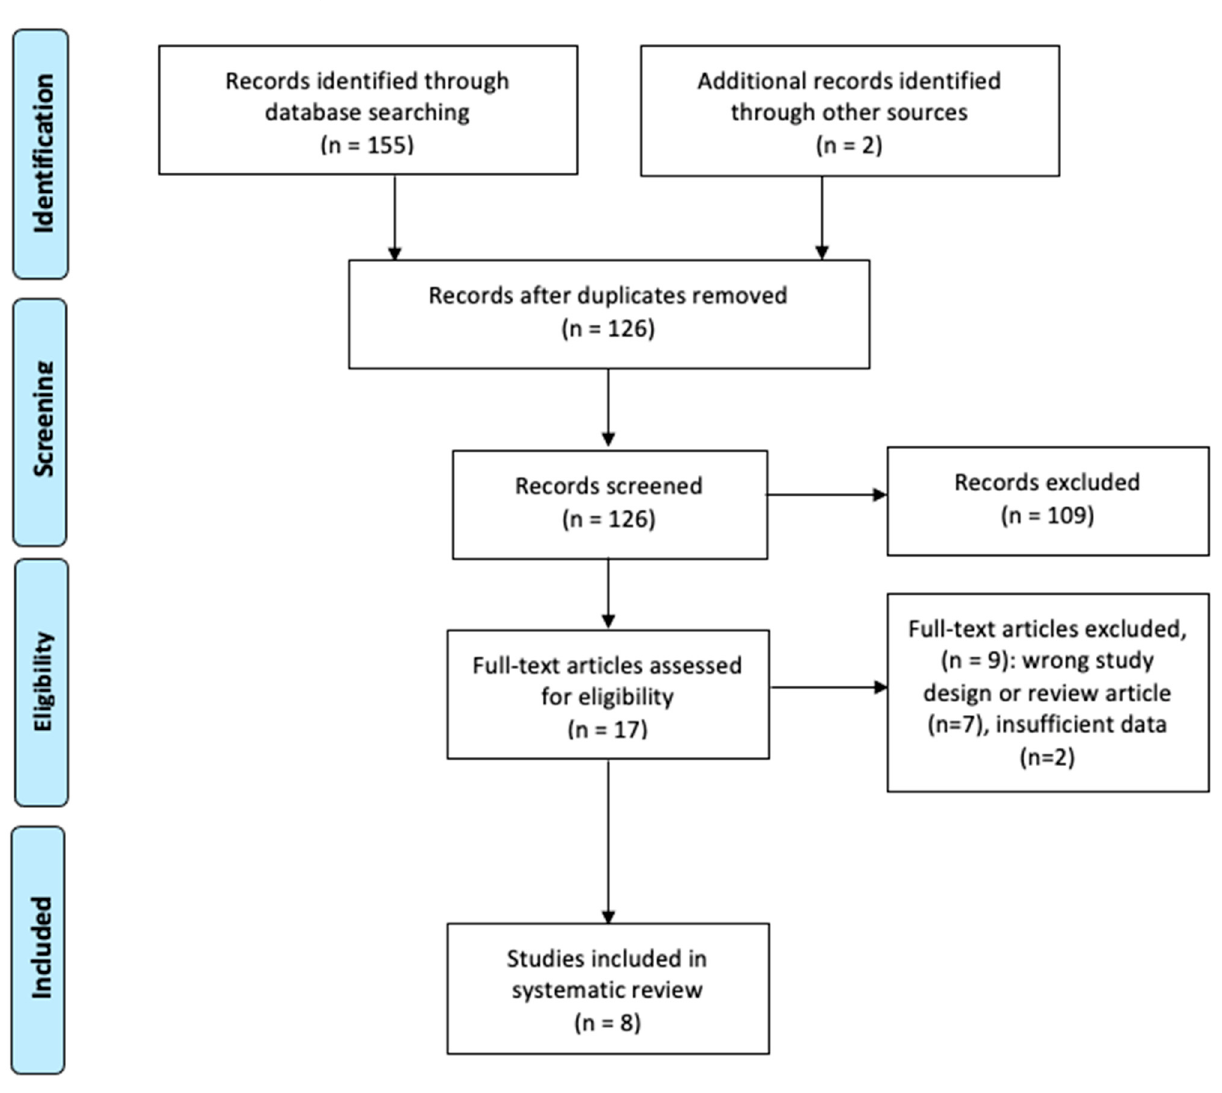
Figure 1. Flow diagram of the literature search and study selection for the systematic review.